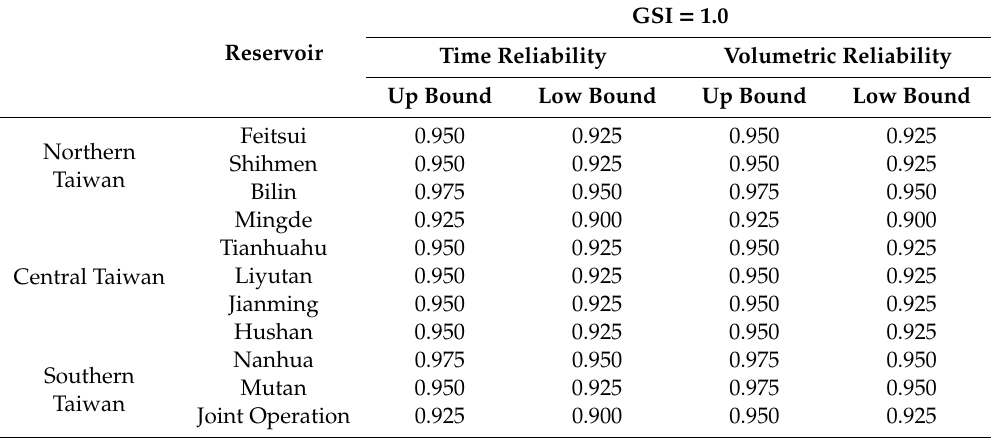
Table 6. Corresponding water supply reliability of GSI =